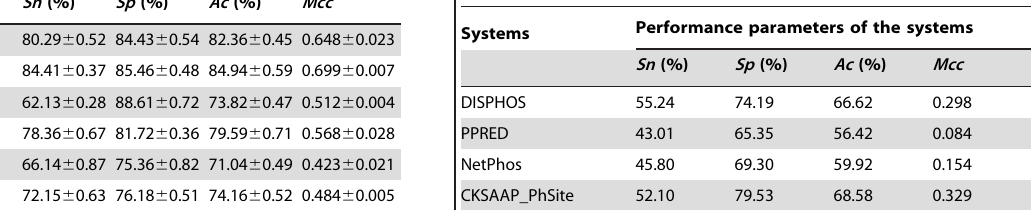
Table 7. Performance of DISPHOS, PPRED, NetPhos, and our predictors in terms of tyrosine (Y) site prediction on the independent dataset.